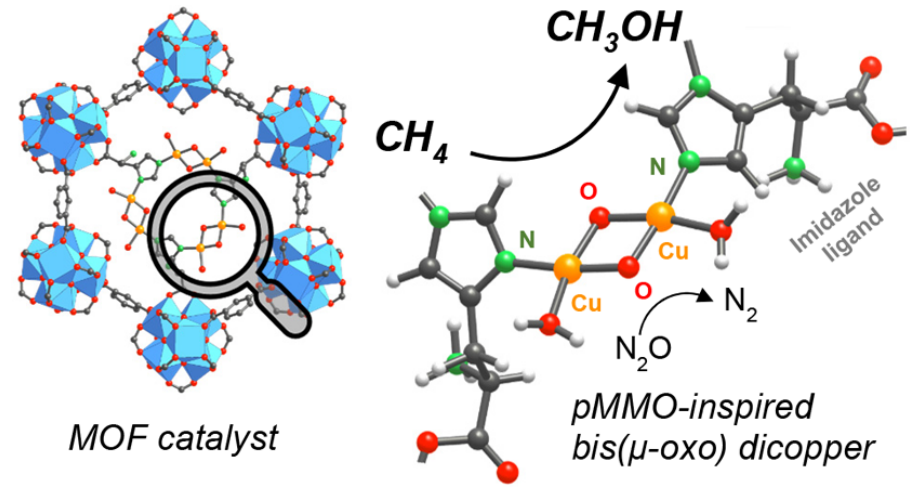
Figure 9. Active sites of Cu/MOF-808 catalyst for partial oxidation of methane to methanol. Repro- duced with permission from ref. [62]. Copyright 2018, American Chemical Society.